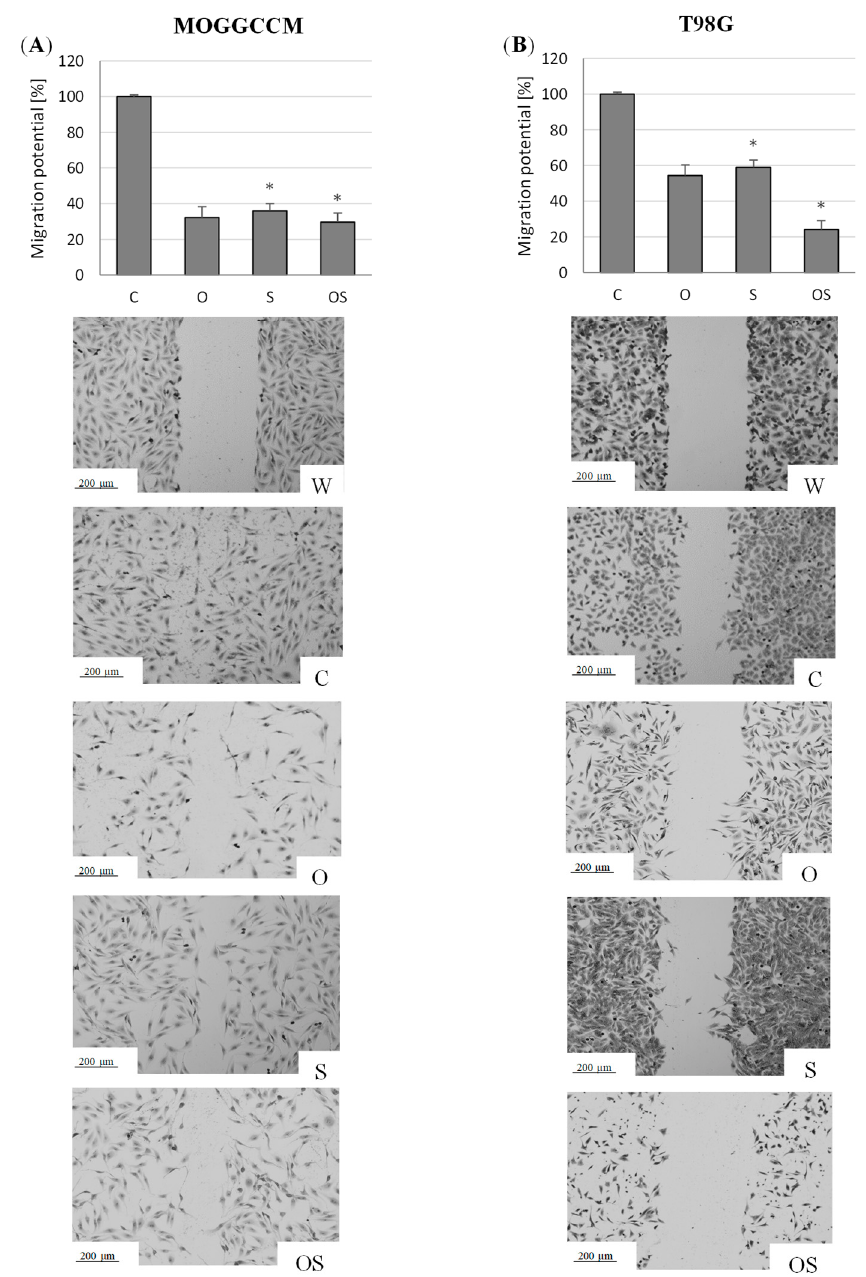
Figure 3. Migration potential of the MOGGCCM ( A ) and T98G ( B ) cells upon osthole and sorafenib treatment presented as the percent of cells within the wound. W—wound, C—control, O—osthole, S—sorafenib; * p < 0.05 .